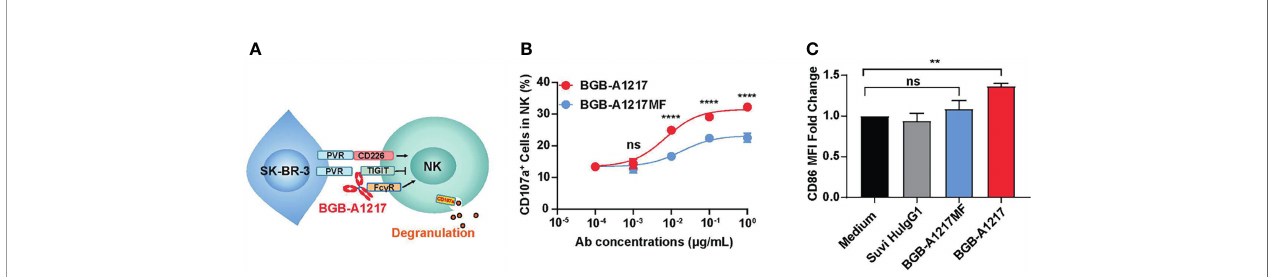
FIGURE 4 | BGB-A1217 activates NK and monocytes in an Fc-dependent manner. (A) schematic diagram of the NK activation assay. The indicated anti-TIGIT antibodies, BGB-A1217 or BGB-A1217MF were incubated with SK-BR-3, and pre-stimulated NK cells from PBMCs of healthy donors. CD107a expression on NK cells was measured by FACS. (B) Proportion of CD107a + cells in total NK cells after the co-culture. Data are shown as mean ± SD. N = 2. Comparison between A1217 and A1217MF at each concentration level (B) was performed using a two-way ANOVA model with Sidak multiplicity adjustment. **** p < 0.0001, ns: no signi fi cant difference. (C) BGB-A1217, but not BGB-A1217MF, up-regulates CD86 on myeloid cells in vitro . Human PBMCs from healthy donors were incubated with 10 m g/mL antibodies as indicated overnight and analyzed by FACS. CD86 MFI fold change to medium group on monocytes was calculated. Data shown as mean ± SEM, pooled from 4 donors. Suvi HIgG1: anti-V3 antibody Suvizumab, human IgG1 format. Comparison of BGB-A1217 and BGB-A1217MF to medium was performed using a mixed-effect model with Sidak multiplicity adjustment. ** p < 0.01, ns: no signi fi cant